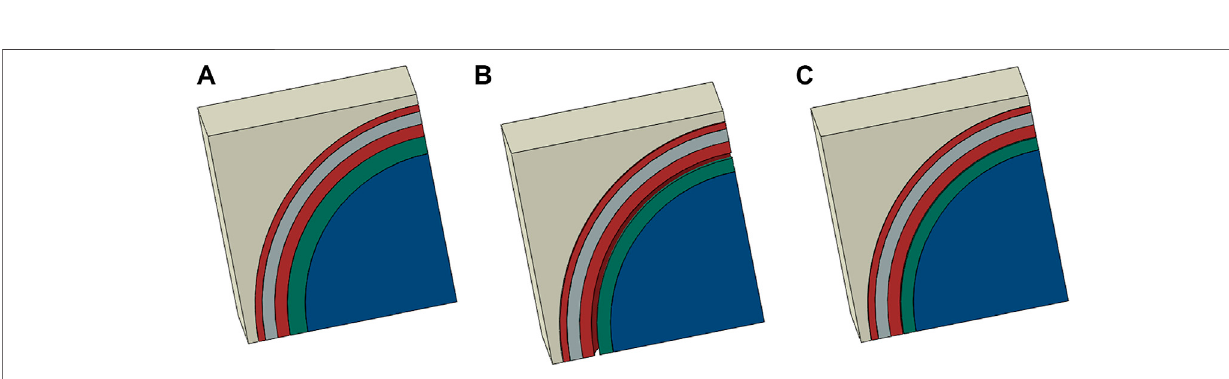
Frontiers in Energy Research |